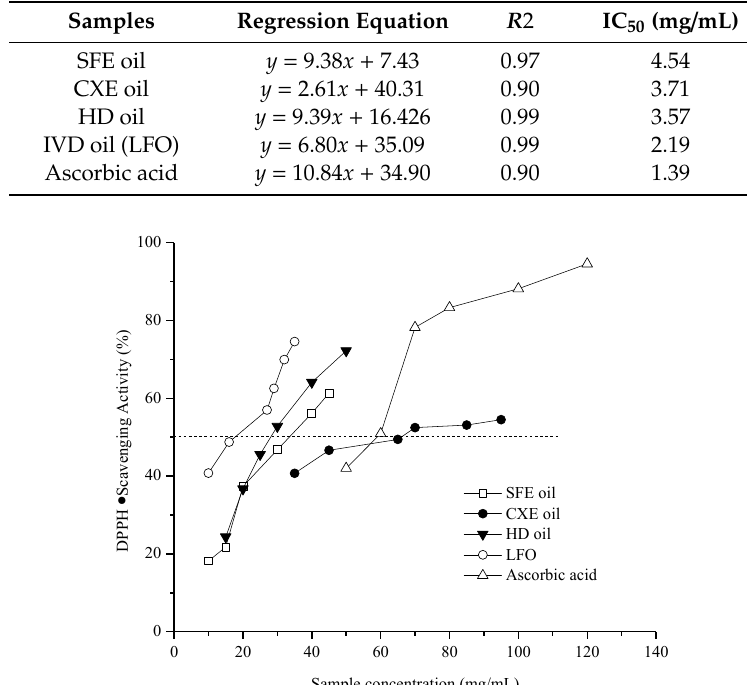
Table 4. Median inhibitory concentration (IC 50 ) of the vetiver oils derived from linear regression.